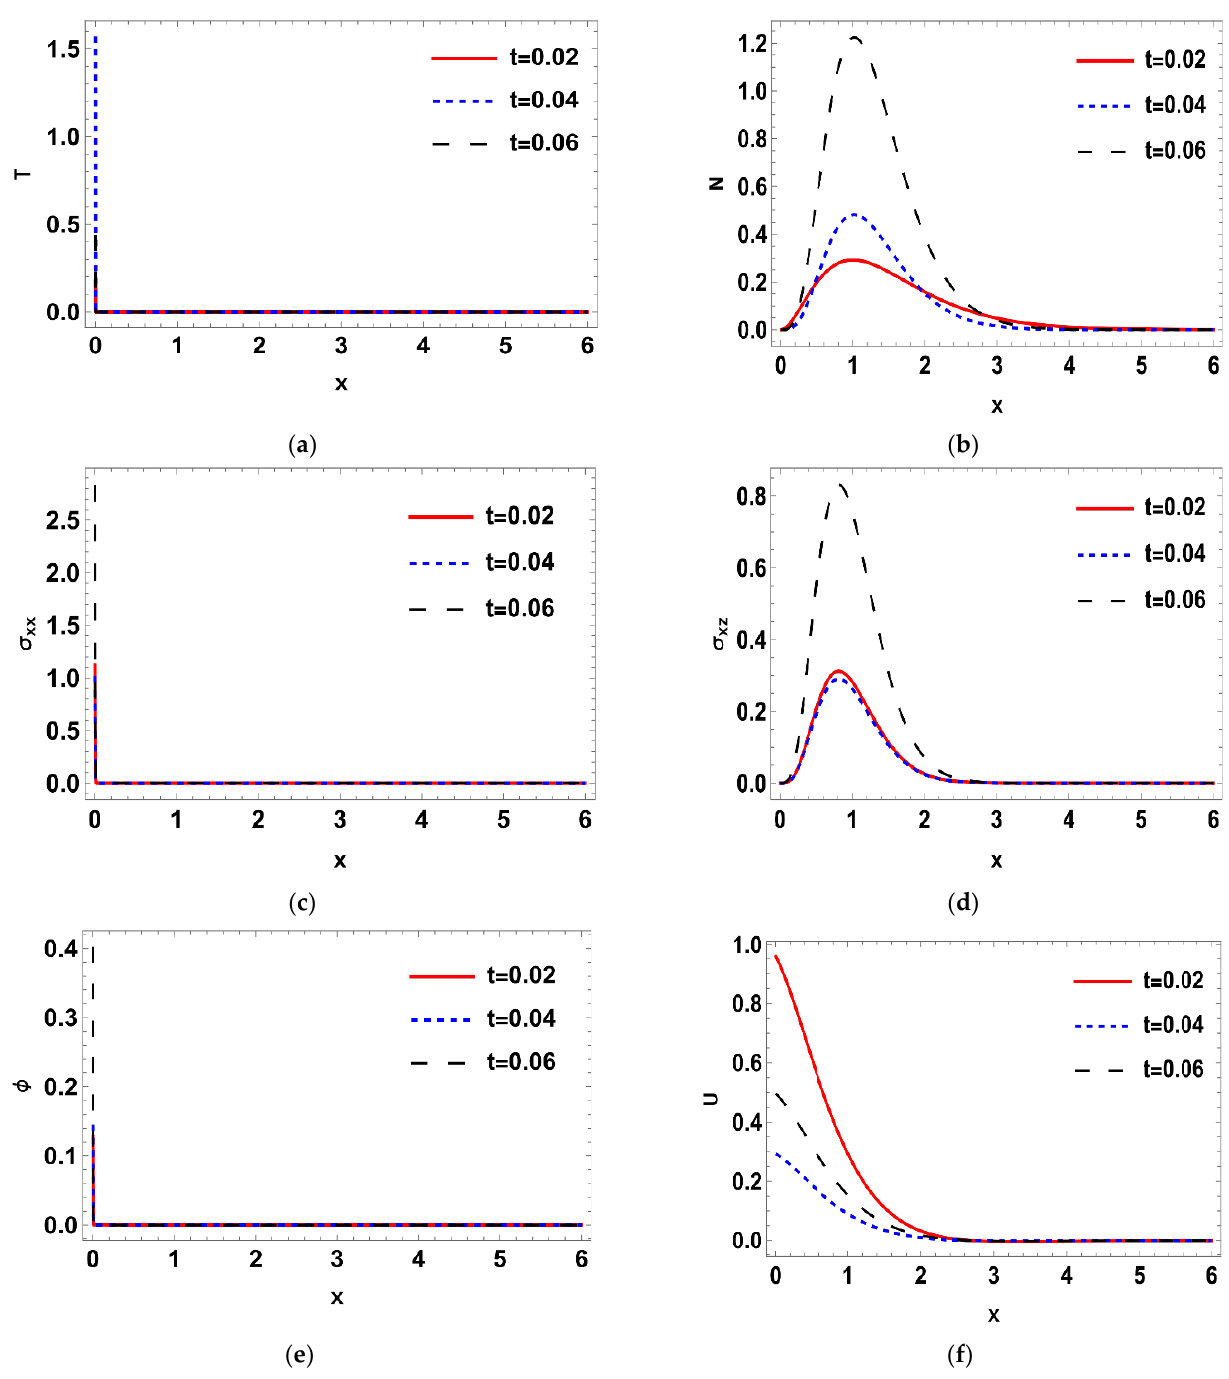
Figure 5. ( a – f ) The deterministic and stochastic distributions of temperature, normal stress, carrier density, displacement and heat conduction distributions along the distance at 0.4 t = in relation to generalized photo-thermoelasticity theory, when 0 a = .